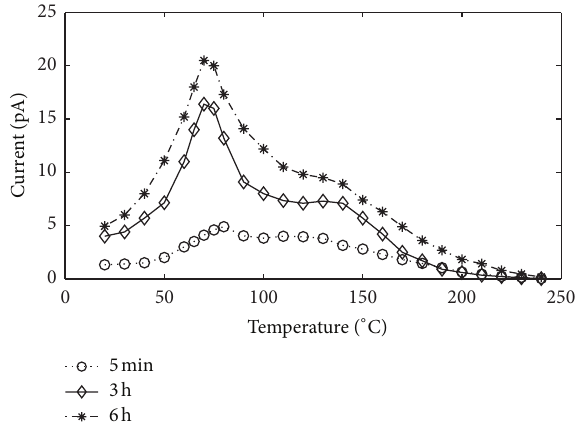
Figure 8: TSDC spectrums of PI exposed to DBD in SF 6 for different treatment